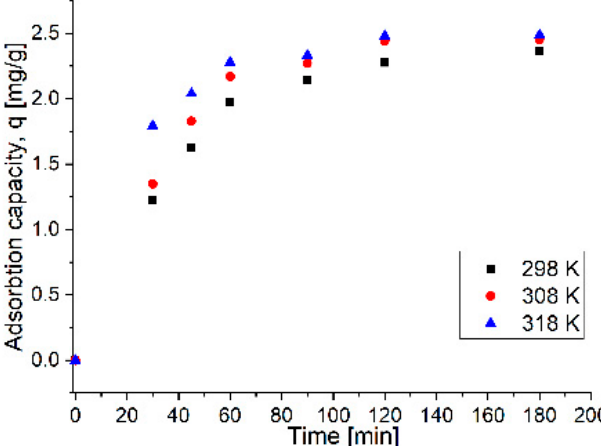
Figure 9. The e ff ect of contact time and temperature for the Pb 2 + adsorption on the Figure 9. The effect of contact time and temperature for the Pb 2+ adsorption on the magnetic nanocomposite MNPs35@SiO 2 .